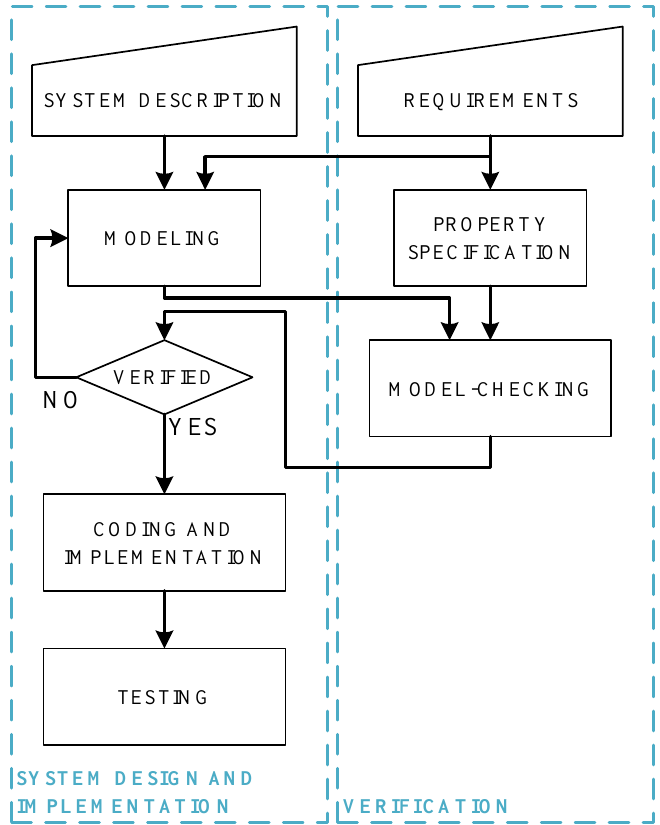
Figure 5. System development and verification stages.